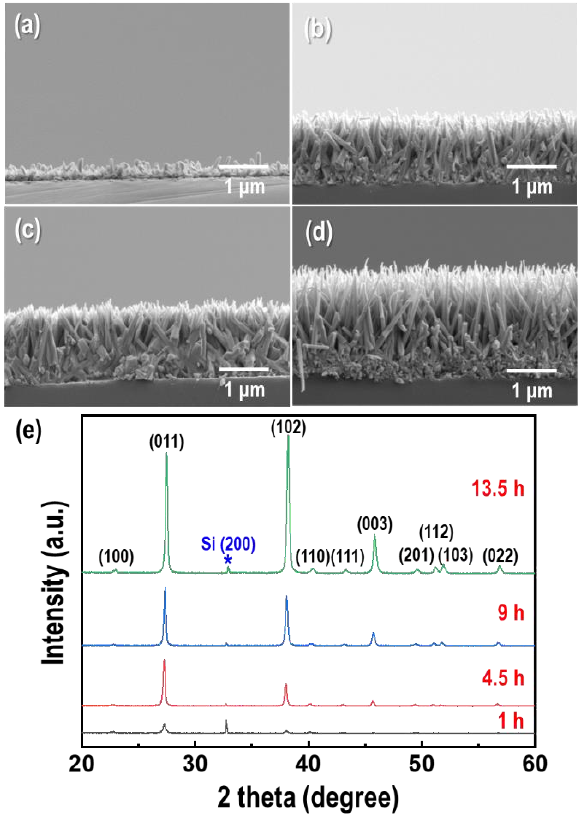
Figure 2. Galvanic displacement reaction (GDR) time dependence of the morphology and dimensions of the Te nanorod arrays. Cross-section field emission scanning electron microscopy (FE-SEM) images of Te nanorod arrays form at ( a ) 1 h, ( b ) 4.5 h, ( c ) 9 h, and ( d ) 13.5 h, respectively. ( e ) Corresponding X-ray diffraction (XRD) patterns of the Te nanorod arrays.